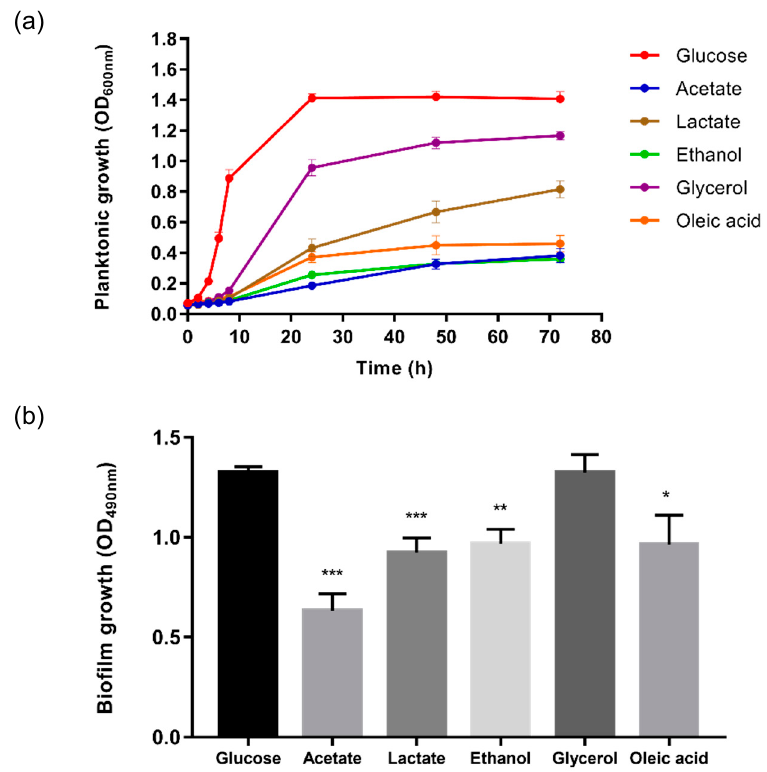
Figure 1. Alternative carbon sources modulate the planktonic and biofilm growth of C. glabrata . ( a ) Planktonic growth of C. glabrata in synthetic complete (SC) media supplemented with 2% glucose, 2% acetate, 2% lactate, 2% ethanol, 2% glycerol, or 0.2% oleic acid and incubated for 72 h at 37 °C; ( b )